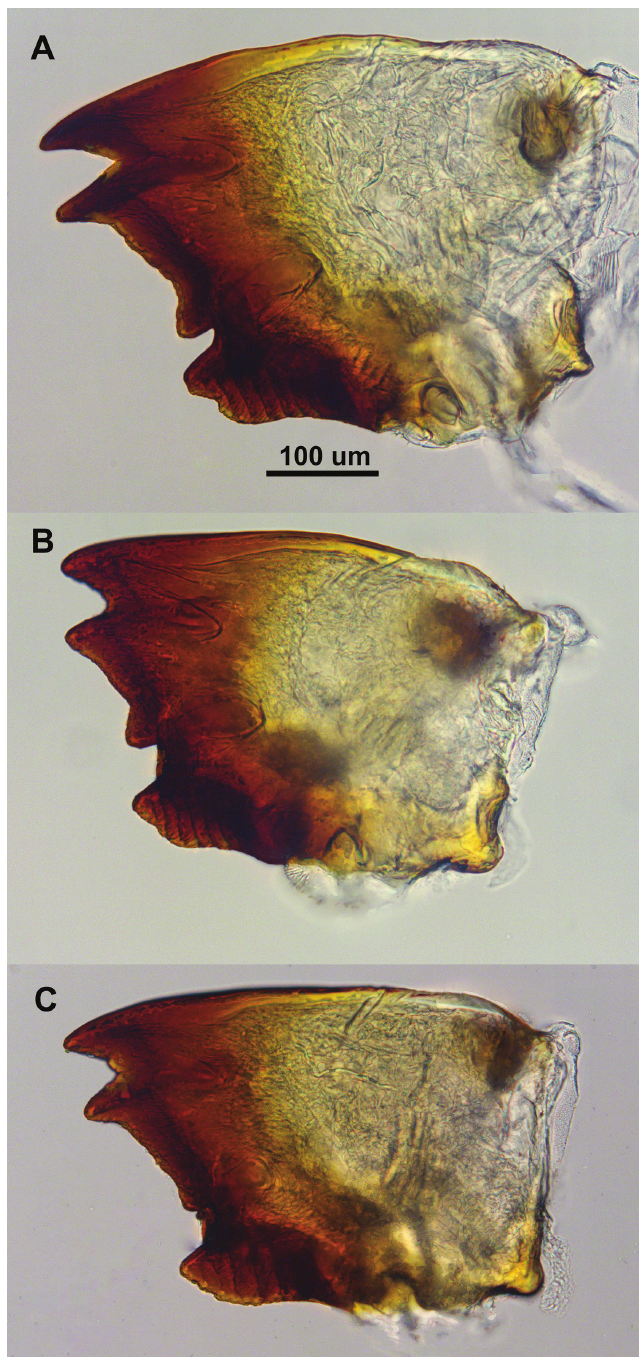
Figure 6. Parvitermes ventral views of left worker mandibles. A P. mexicanus comb. n. B P. mesoameri- canus sp. n. C P. yucatanus sp.